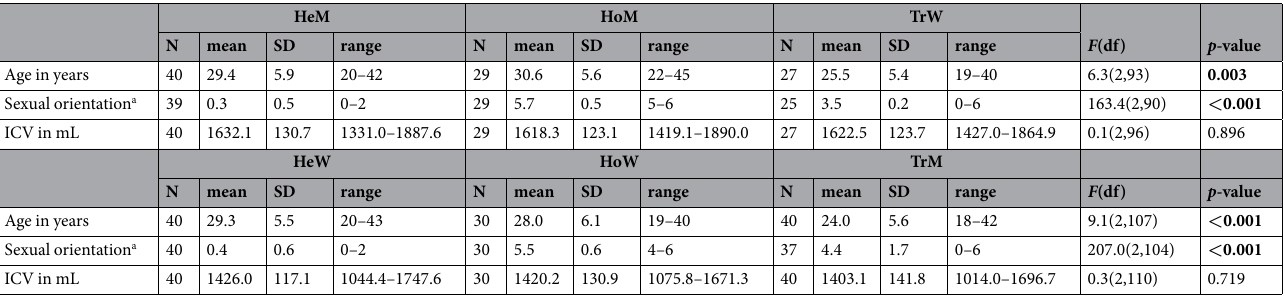
Table 1. Subject characteristics. a Sexual orientation was assessed using the self-report Kinsey scale 57 , scores range from 0 = “exclusively heterosexual” to 6 = “exclusively homosexual” in relation to one’s birth-assigned sex; ICV = total intra-cranial volume; HeM = heterosexual cisgender men; HoM = homosexual cisgender men; TrW = transgender women; HeW = heterosexual cisgender women; HoW = homosexual cisgender women; TrM = transgender